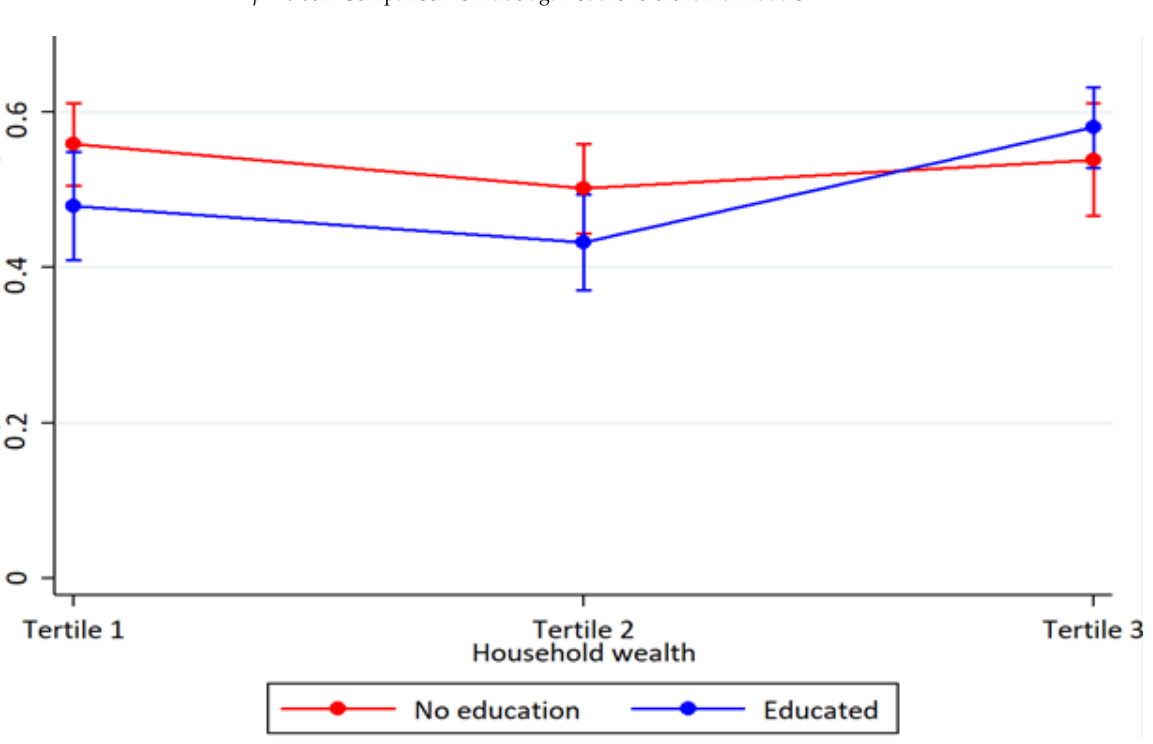
Figure 2. Probability of skilled birth assistance use by household wealth and maternal education with 95% confidence intervals.